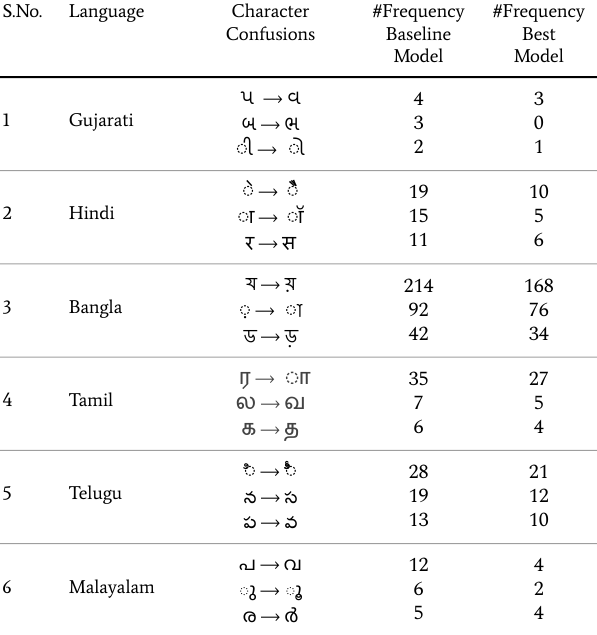
Figure 12. Examples of character confusions over real datasets with models trained on Baseline 2 and the best resultant model trained so